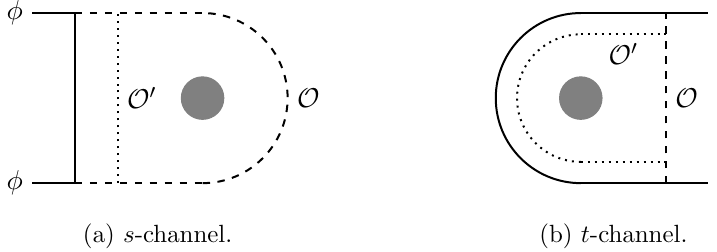
Figure 11. Poles in a ((cid:1) ; J ) for other double-twist families [ OO ] in h (cid:30)(cid:30) i shift by anomalous dimensions through sums over multi-twist families [ (cid:30)(cid:30) O 0 O 0 ] in the t